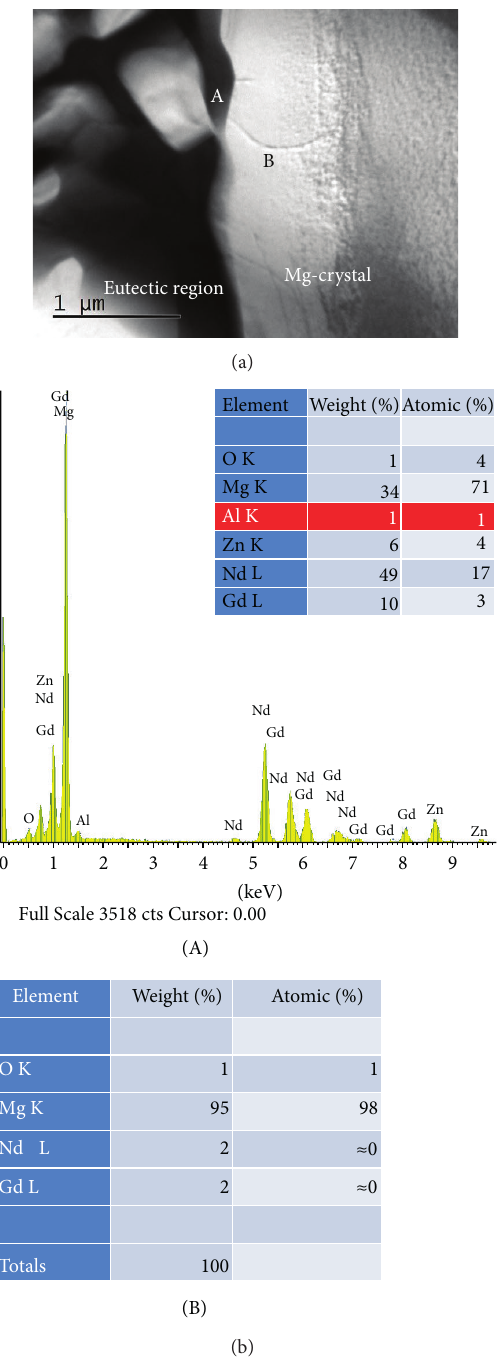
Figure 2: (a) BF TEM picture of a eutectic region of EL 21 + Al 2 O 3 -AlOOH composite; (b) EDS spectra of the A and B areas.